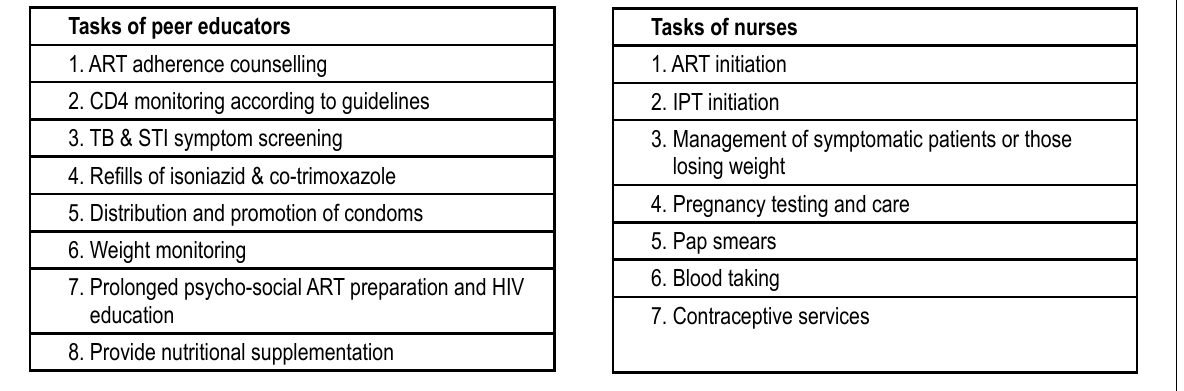
Fig. 1. Service package delivered in pre-ART services by various cadres of